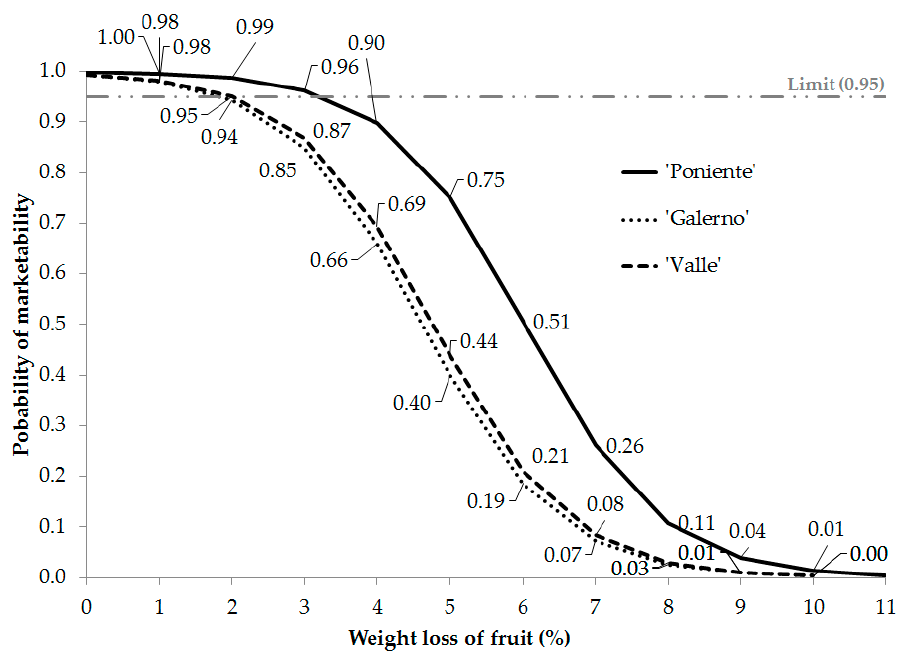
Figure 9. Probability of marketability based on fruit loss percentage during storage for the Galerno, Poniente, and Valle cultivars.